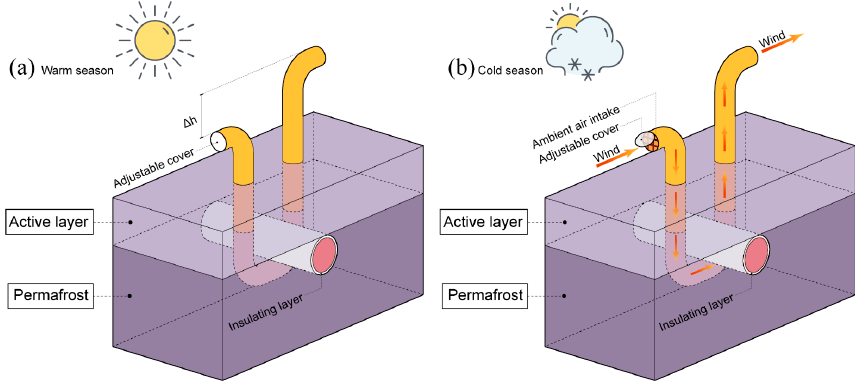
Figure 6. Schematic diagram showing the cooling effect of the U-shaped air-ventilated pipe in ( a ) warm seasons and ( b ) cold seasons.